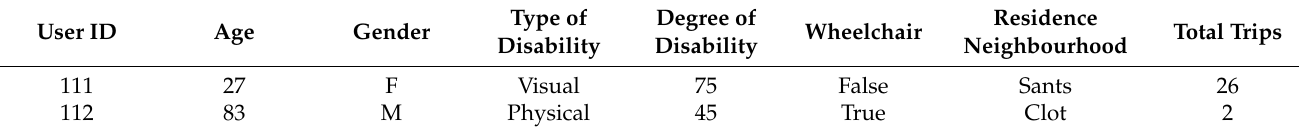
Table 1. Examples of the structure of the SMTS user dataset. Each row in the dataset represents a different user and contains information about the user identifier, age, gender, type of disability, degree of disability, use of a wheelchair, neighbourhood residency and the total number of trips made.